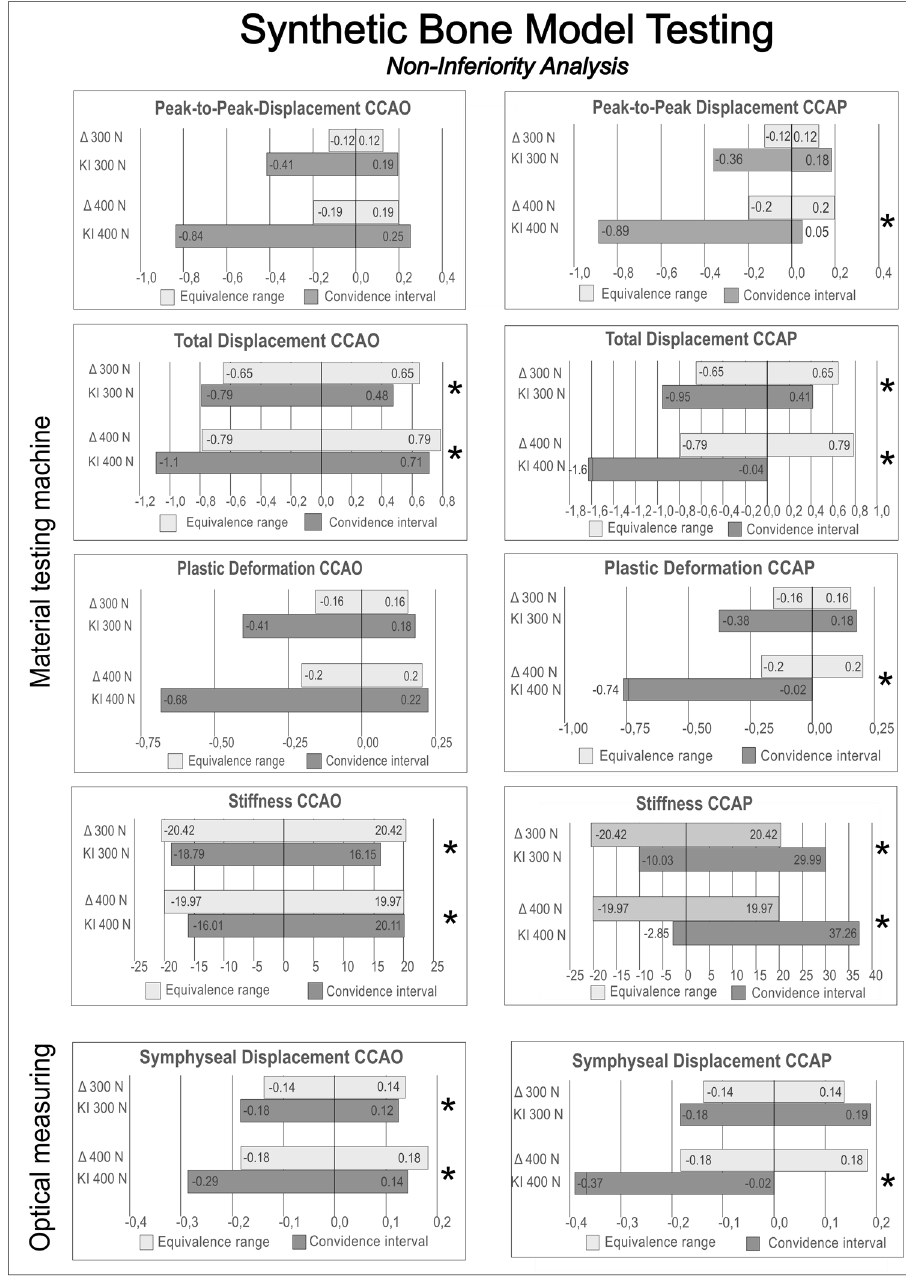
Fig. 5 Results of the synthetic bone model biomechanical testing - non-inferiority testing. Non-inferiority testing of the synthetic bone models con fi rmed equivalence of SP and cable-clamp (CCAO or CCAP) fi xation methods for several of the test parameters (asterisk). Absence of non-inferiority does not indicate lower stability because the non-inferiority test could not be conducted for some